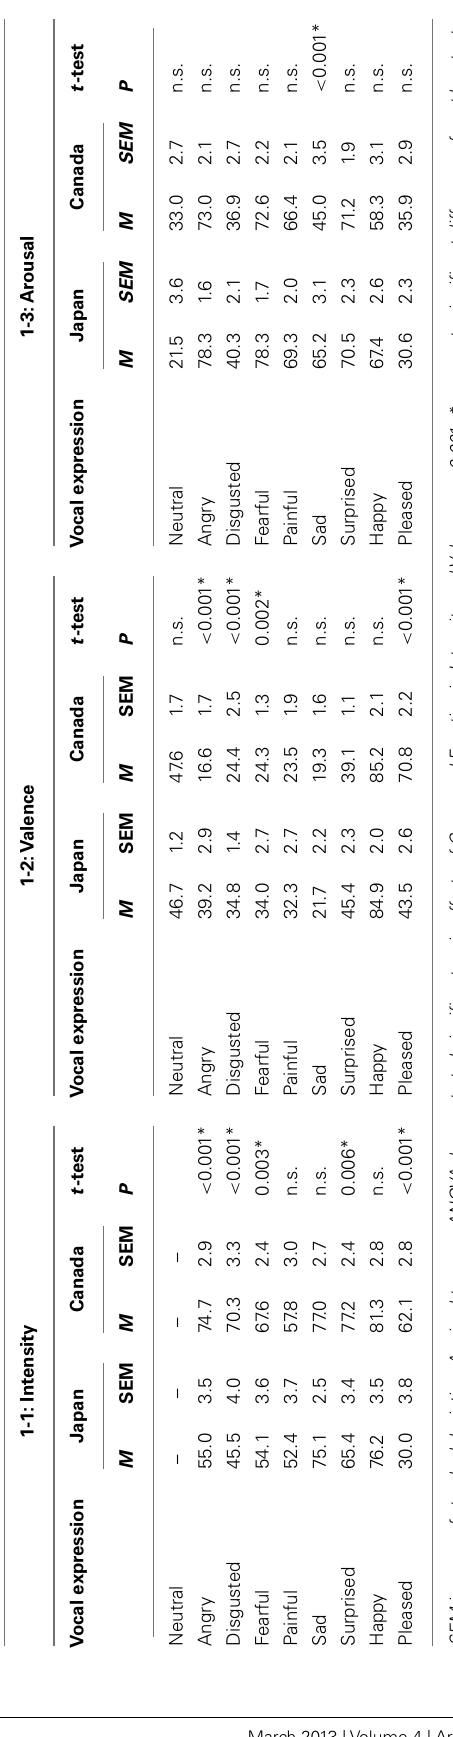
t = − 6.737: Table 1 ; Figure 1A ).